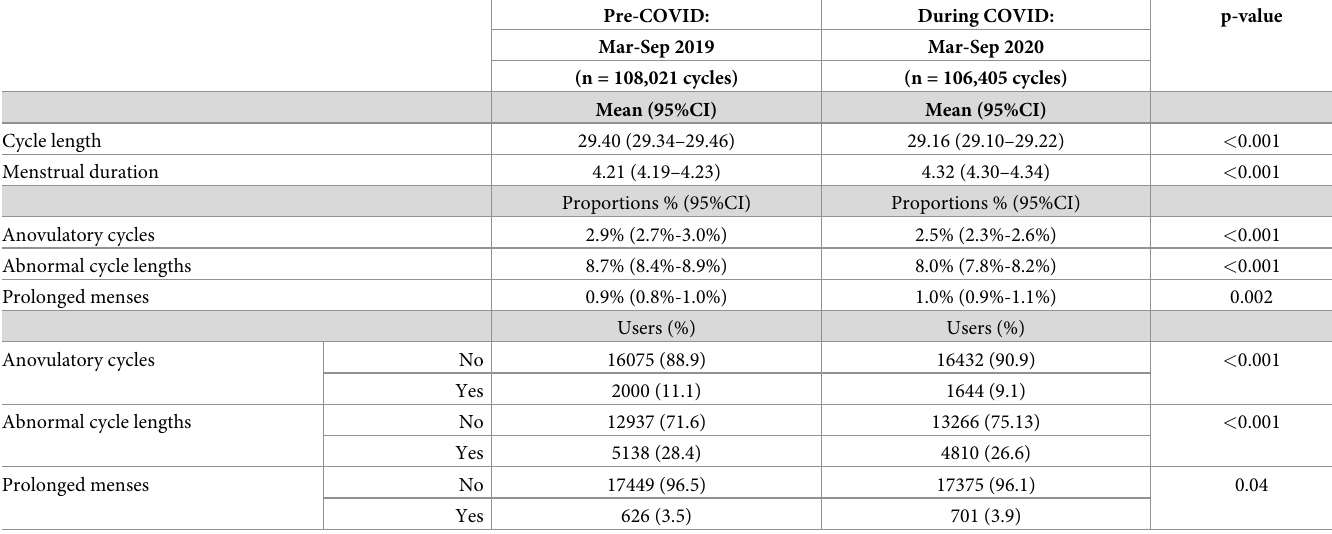
Table 2. Menstrual characteristics and abnormalities prior to and during the COVID-19 pandemic (n = 18,076 users; N = 214,426 cycles).